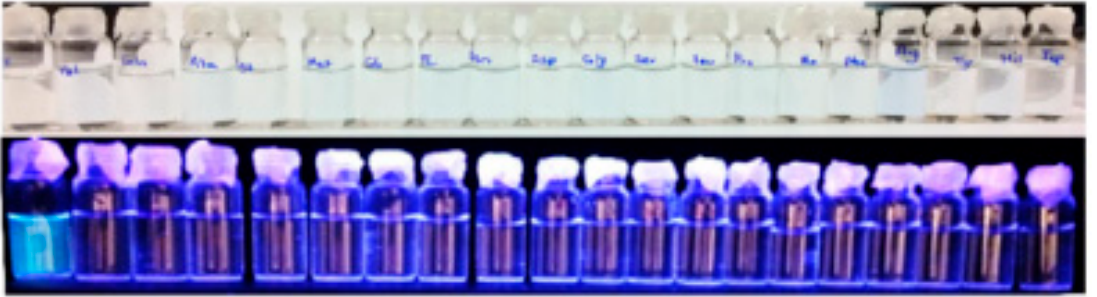
Figure 13. The effect of different amino acids on copper sulfate solution (pH = 12). From left to right: with Cys, Val, Gln, Ala, Lys, Met, Glu, Thr, Asn, Asp, Gly, Ser, Leu, Pro, Ile, Phe, Arg, Tyr, His, Trp, respectively (Copyright Ref [148], Springer publications).